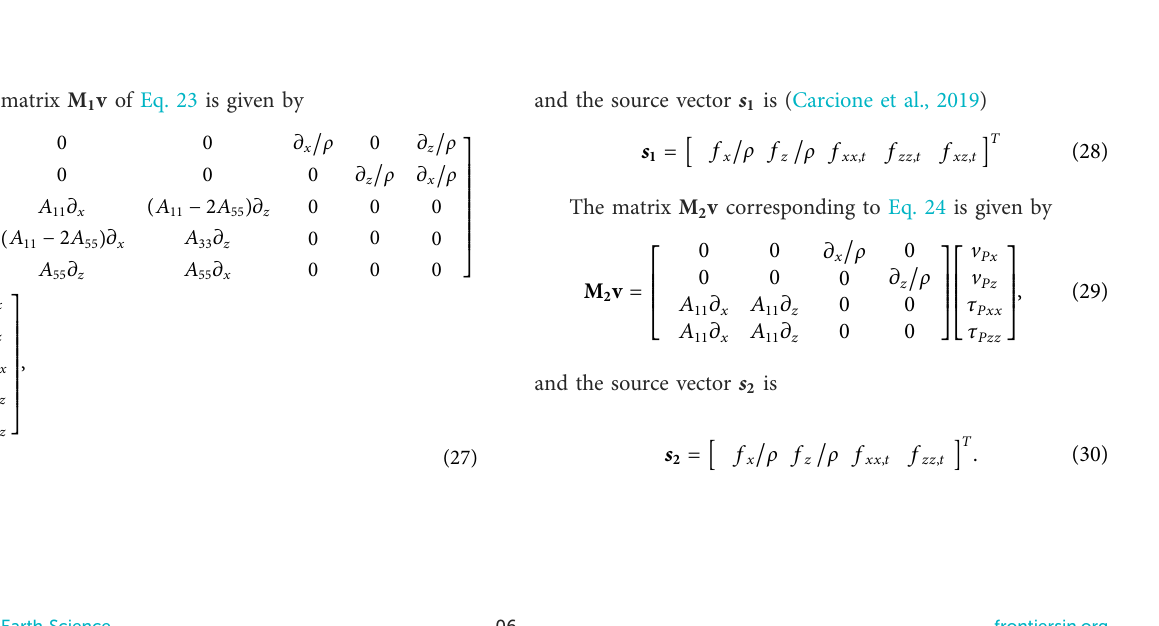
Frontiers in Earth